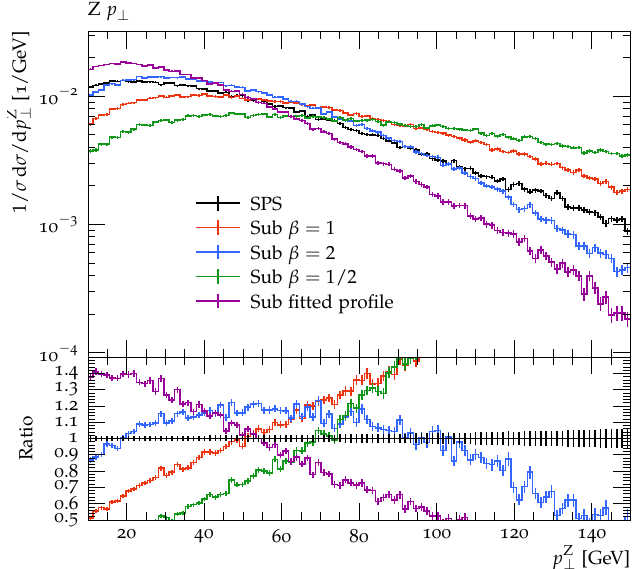
Figure 12 . Transverse momenta of the Z 0 bosons as produced by the SPS and subtraction terms. The subtraction term corresponding to a Gaussian distribution g ( k ? ; y ) is given for several values of (cid:12) . The (cid:12)tted pro(cid:12)le corresponds to a decreasing Gaussian distribution g ( k ? ; y ). The SPS setup is the reference in the ratio plot. The histograms are normalised to unity.